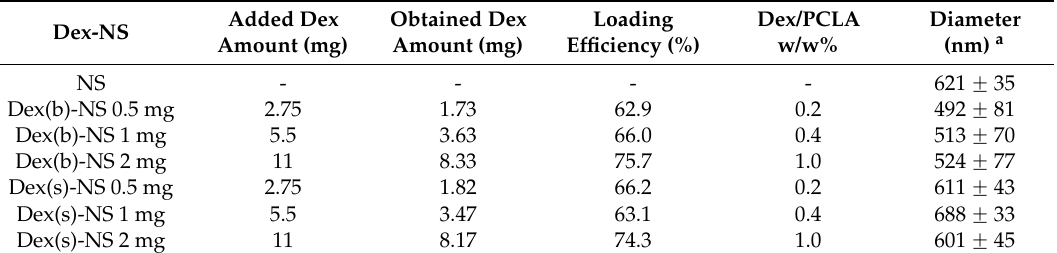
Table 1. Loading efficiencies and diameters of electrospun NS, Dex(b) ‐ NS, and Dex(s) ‐ NS.